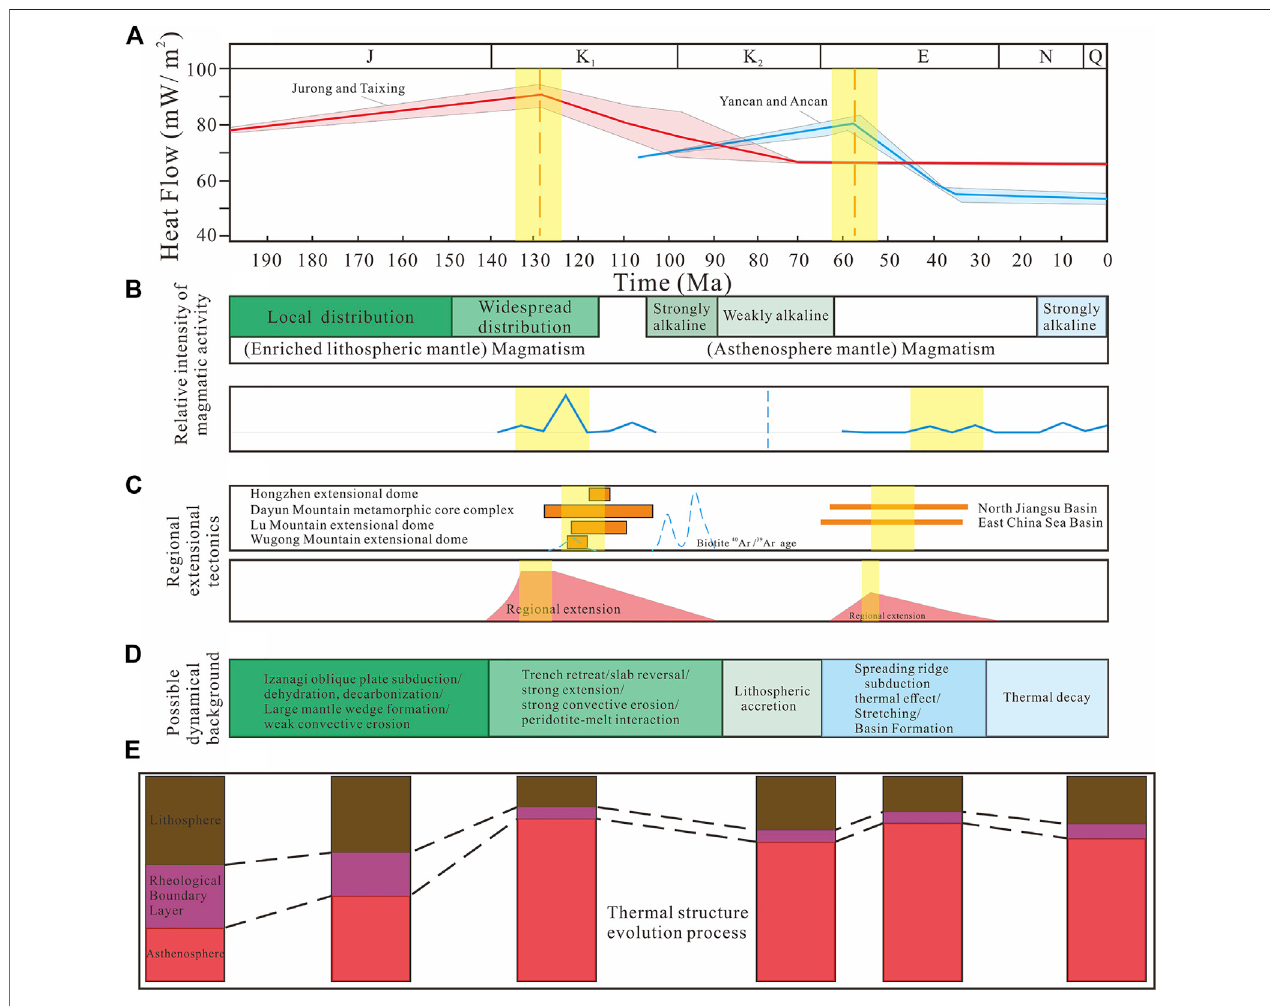
FIGURE 9 | The thermal regime transition process of the Lower Yangtze Craton in Mesozoic and Cenozoic ( (A) thermal history evolution (modi fi ed from Zeng (2005)); (B) relative intensity of magmatic activity (data are from https://data.mendeley.com/datasets/yjjx5fvhvm/2 and https://github.com/CodrIocas/Oxygen); (C) regionalextensionaltectonics(modi fi edfromLinand Li(2021)); (D) possible dynamicalbackground; (E) schematicillustration oftheevolutionprocess ofthelithospheric thermal structure of cratons in East China (revised from He and Zhang (2018))).